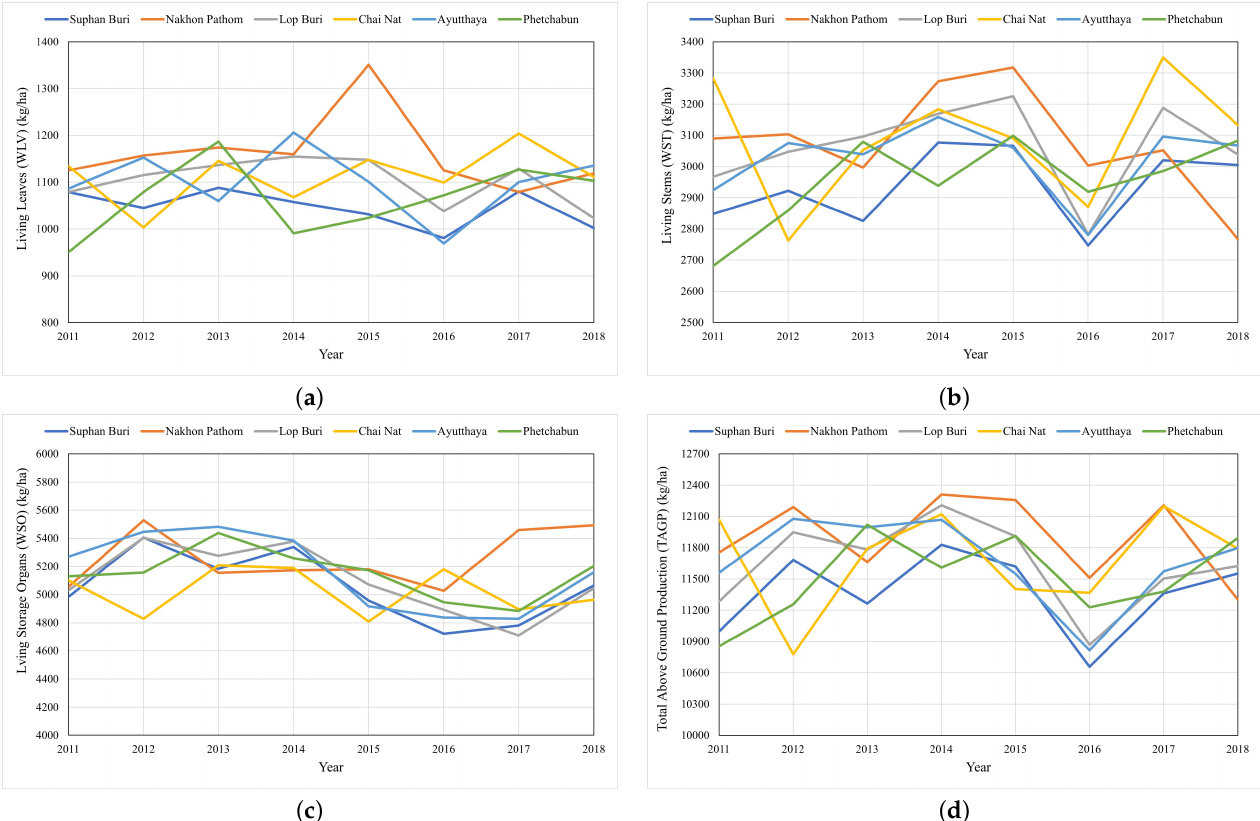
Figure 4. The results of simulating the weight of rice variety Suphan Buri. ( a ) WLV, ( b ) WST, ( c ) WSO, and ( d )